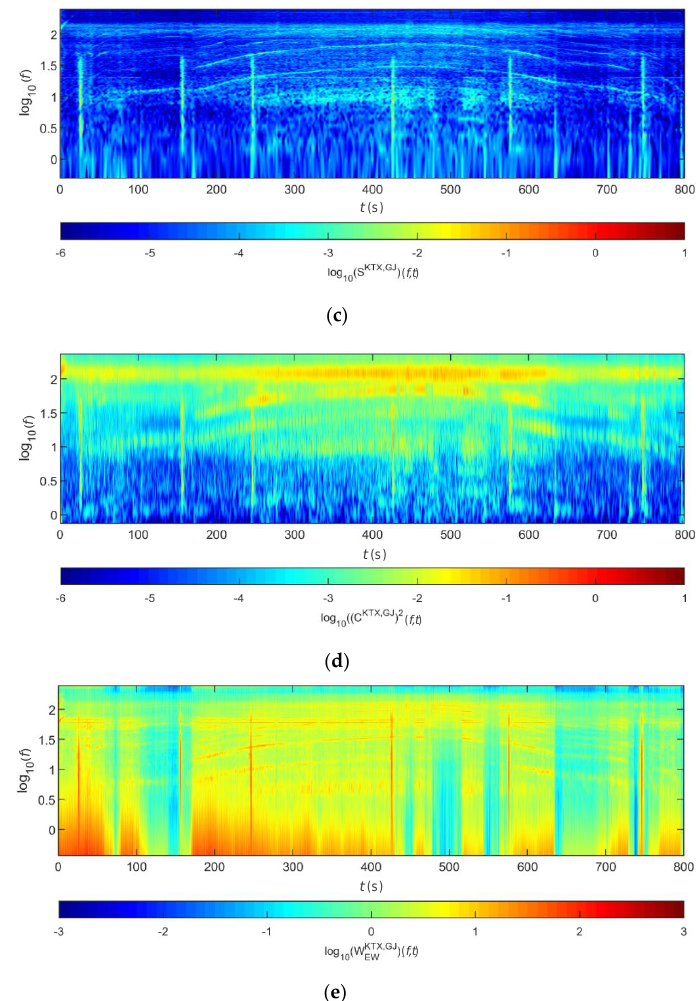
Figure 23. Combination of train data with the Gyeongju earthquake data (scaled to 2400-year return period): ( a ) velocity; ( b ) lateral acceleration time series; ( c ) STFT; ( d ) WT; ( e ) WVD.